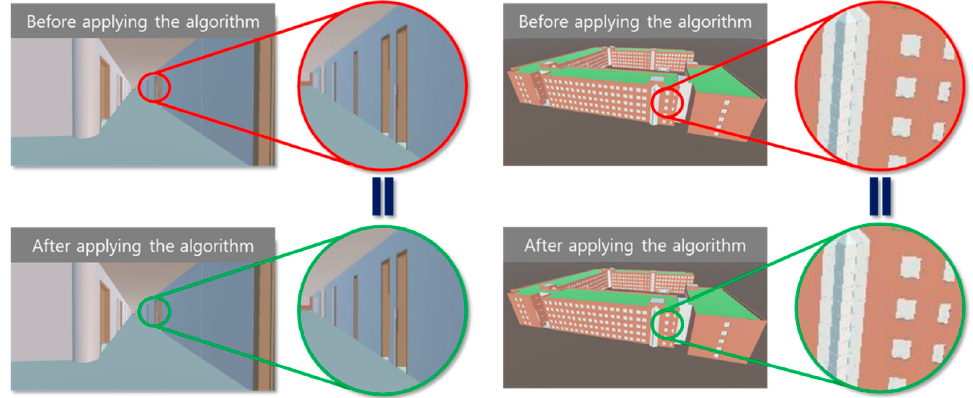
Figure 9. SKKU steel bridge in 3D engine before and after applying algorithm.